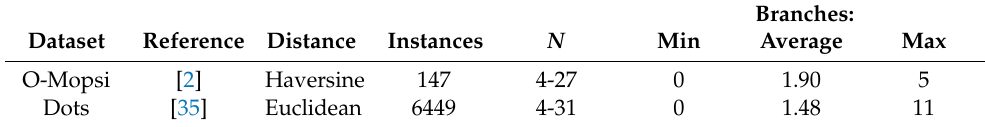
Table 1. Datasets used in the experiments.